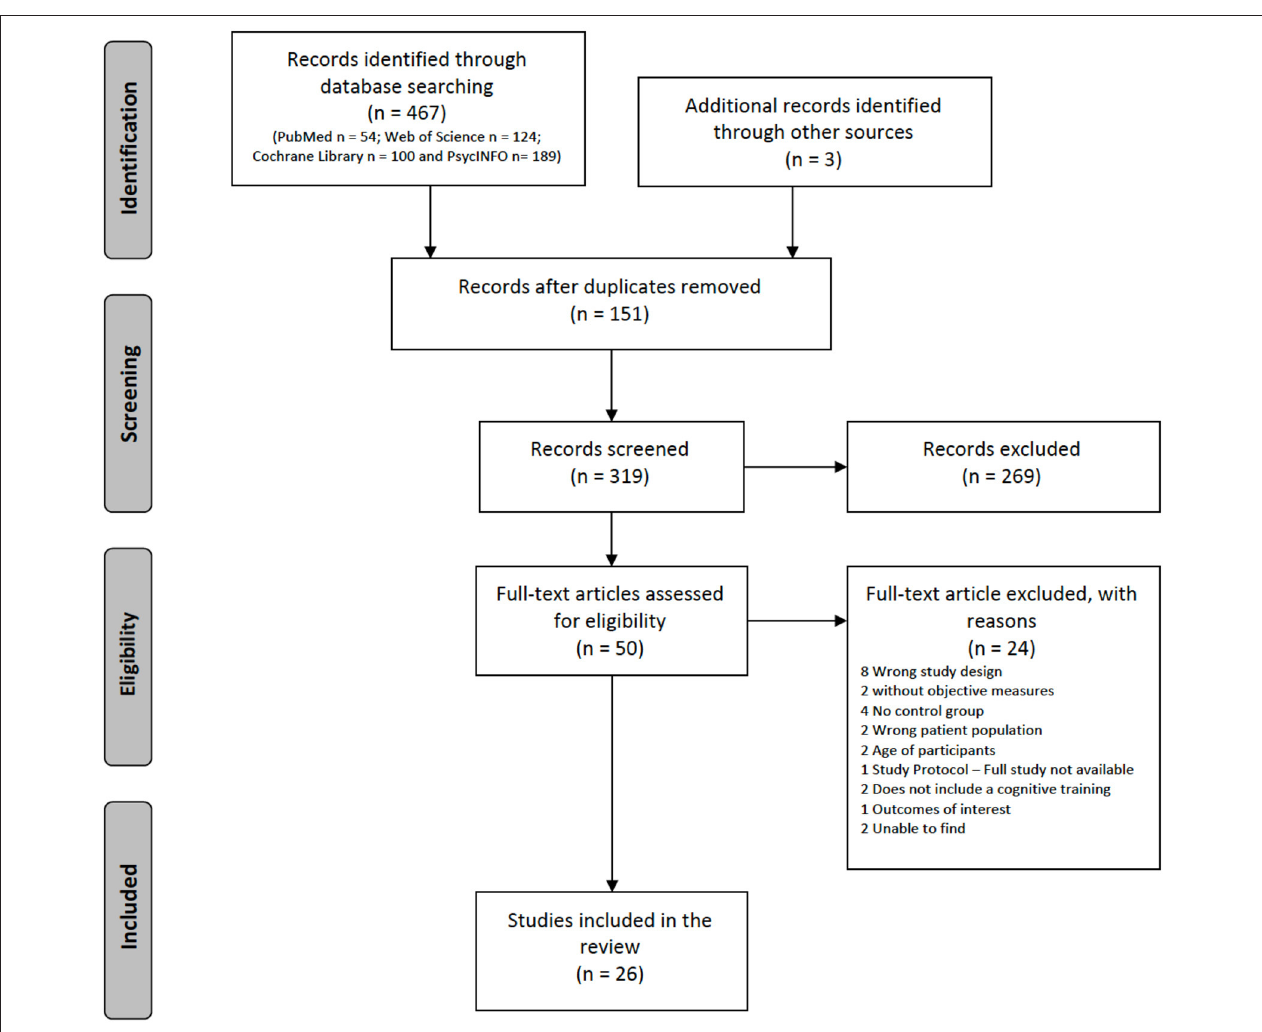
FIGURE 1 | Preferred reporting items for systematic reviews and meta-analyses (PRISMA) flow